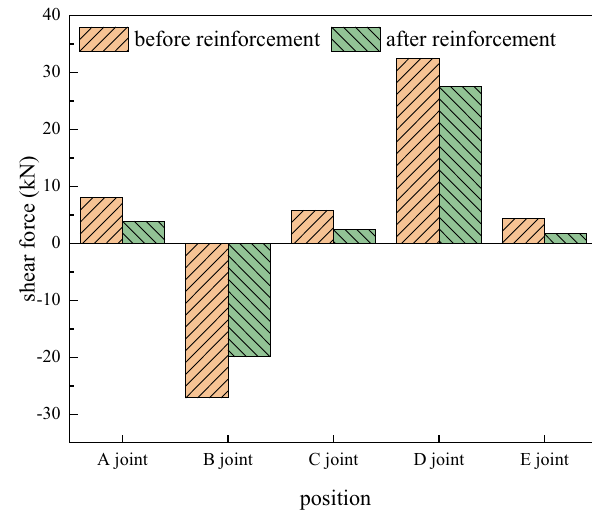
Fig. 13 The comparison of bending moment